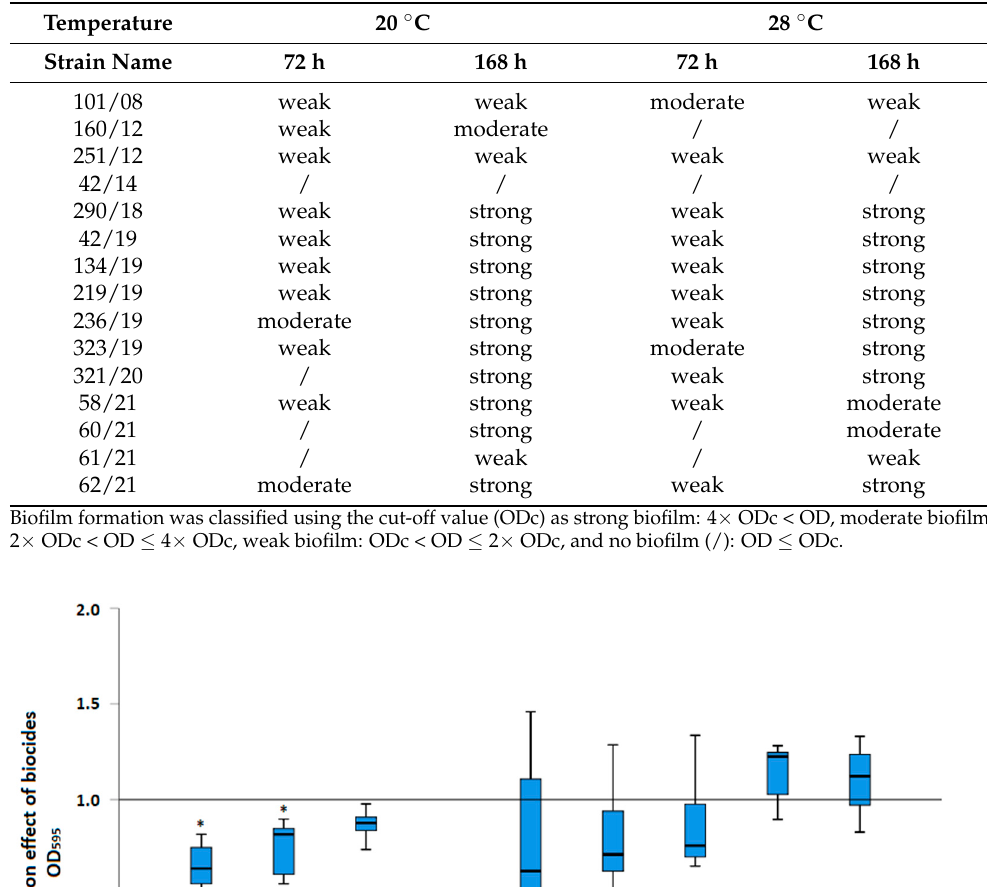
Table 2. Biofilm-forming ability of S. Infantis isolates on polystyrene at two temperatures and